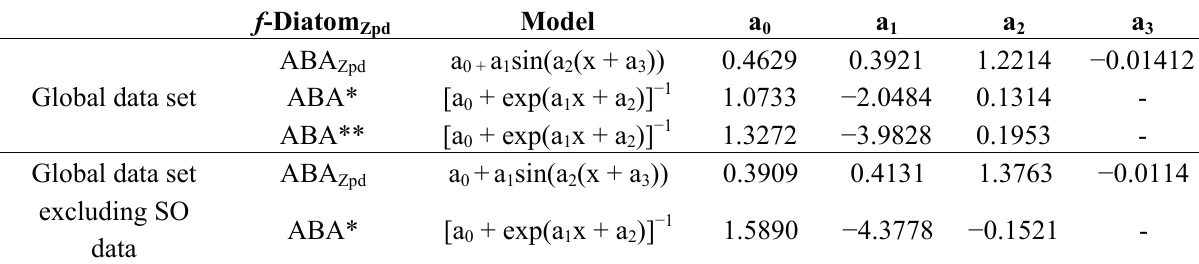
and their respective Zpd